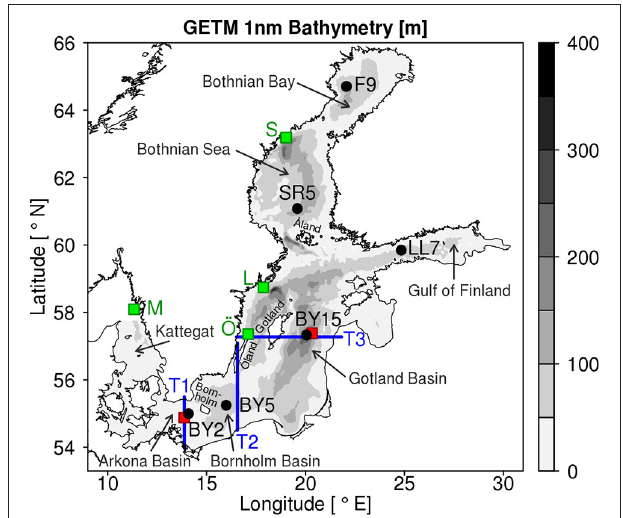
FIGURE 1 | Locations of the used monitoring stations for the assessment of temperature and salinity (black dots) and current velocities (red squares) as well as the analyzed transects (blue lines) in the Baltic Sea. The background color (gray shading) shows the bathymetry [m] from the GETM-1 nm-run. Exemplary stations for atmospheric wind data comparison are shown as green squares. See text for further